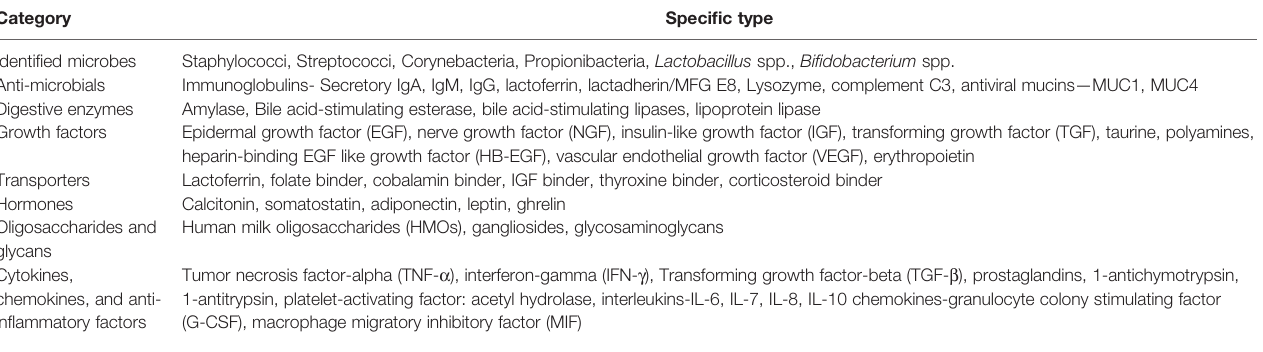
TABLE 2 | Bioactive molecules and identi fi ed microbes in breast milk.